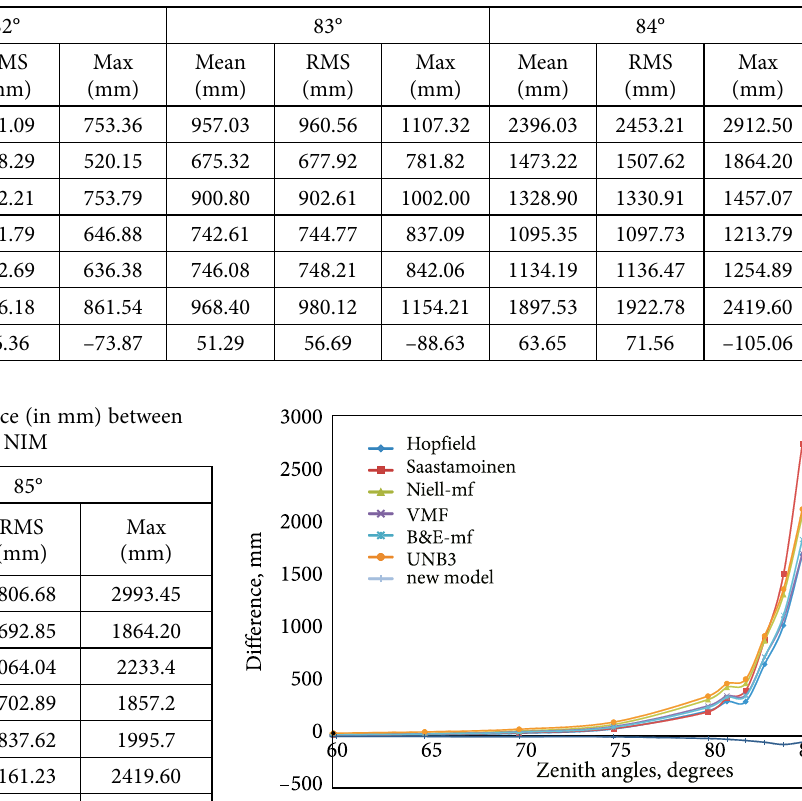
Fig. 2. Difference in mm for Helwan station, january